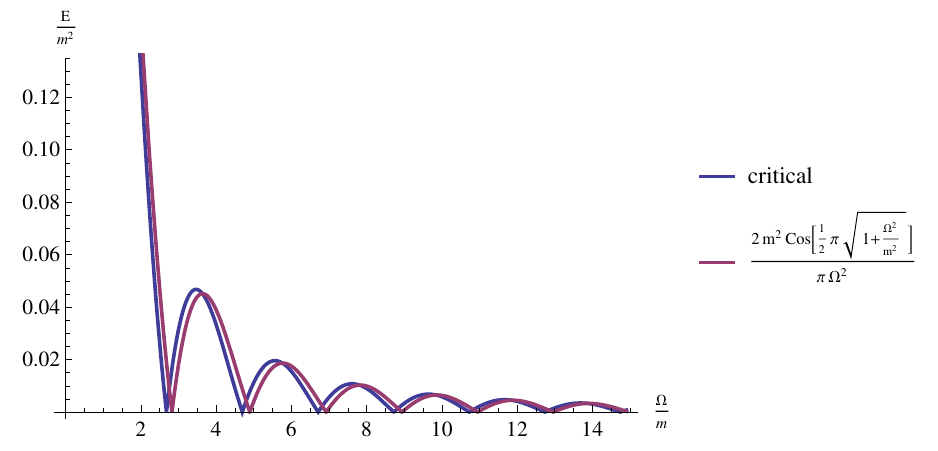
Figure 12 . A critical solution for b ( (cid:26) ) obtained by numerically solving the non-linear full equation of motion and a linear perturbative solution of eq. (6.16) for (cid:10) = 50. Note that we have used z 2 = 1 = (1 + (cid:26) 2 ) and m = 1.